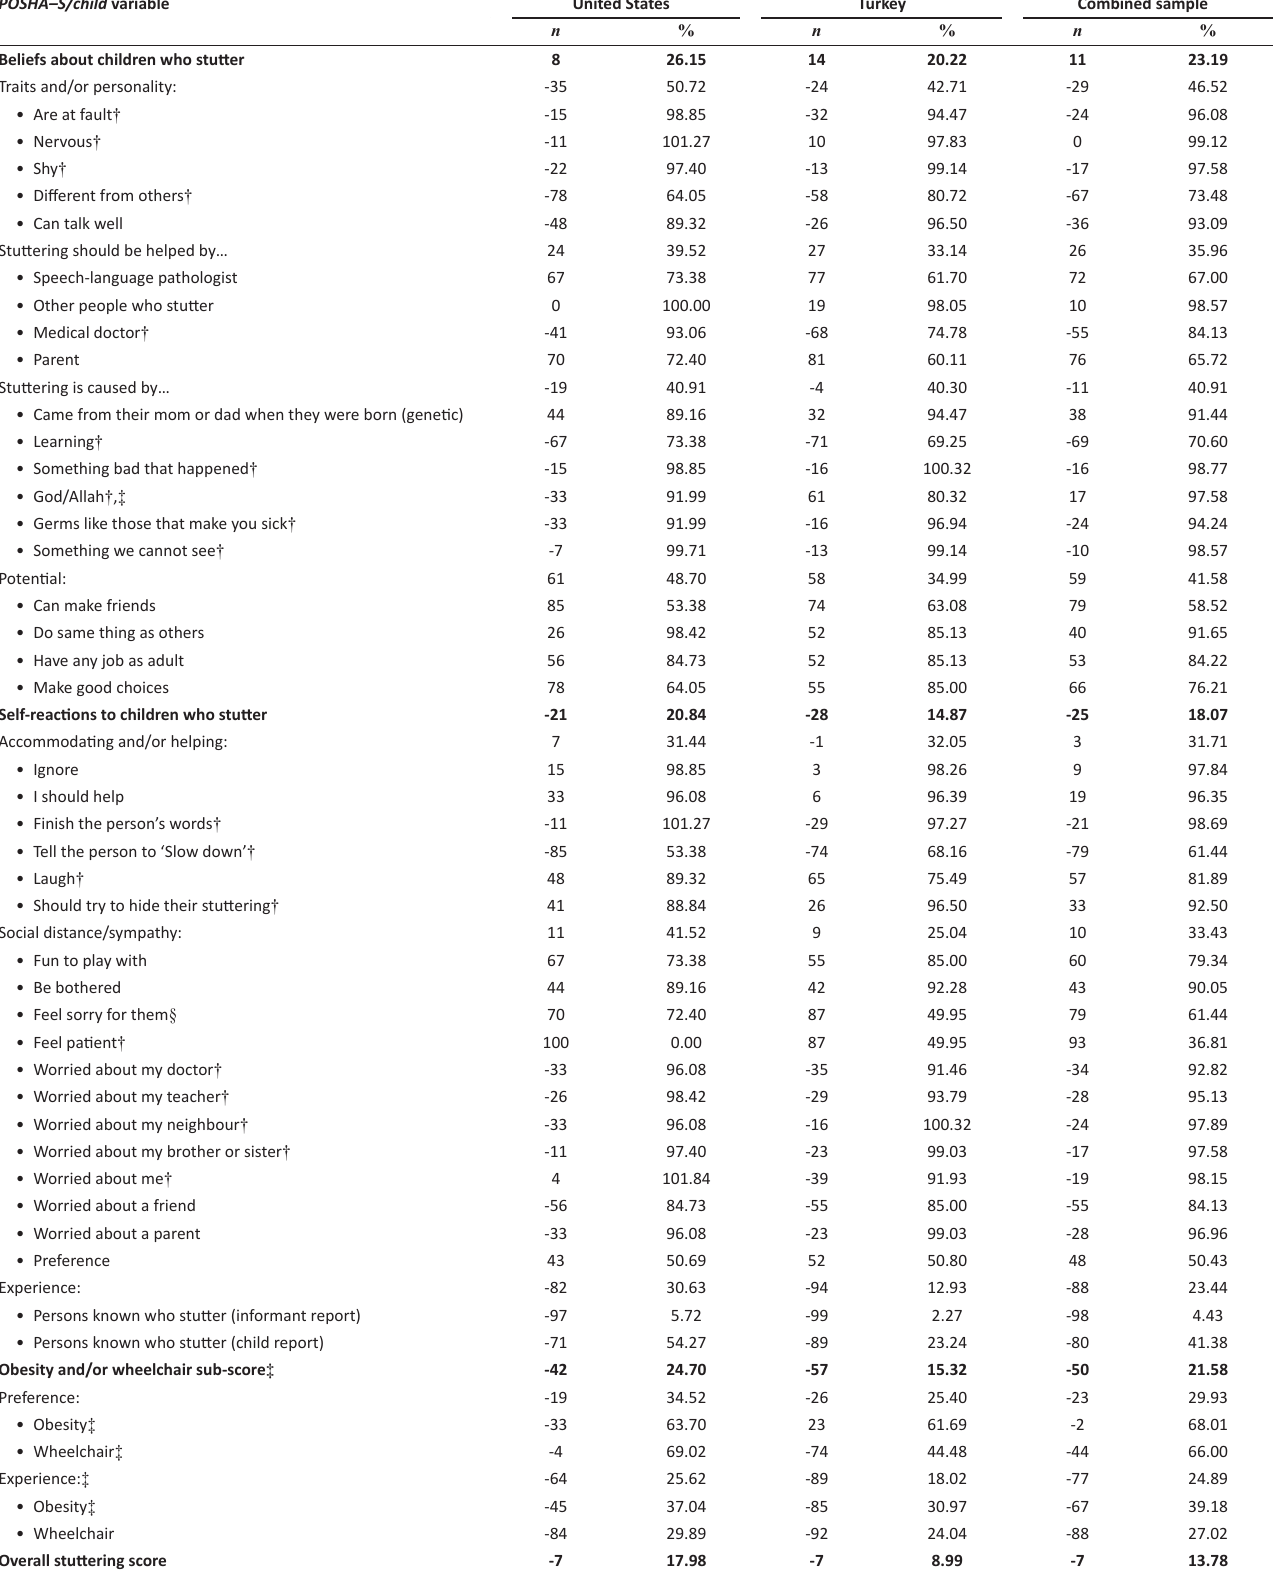
TABLE 1: Public Opinion Survey on Human Attributes–Stuttering/Child ( POSHA–S/Child ) mean stuttering attitude ratings and standard deviations in parentheses for American and Turkish samples and both samples